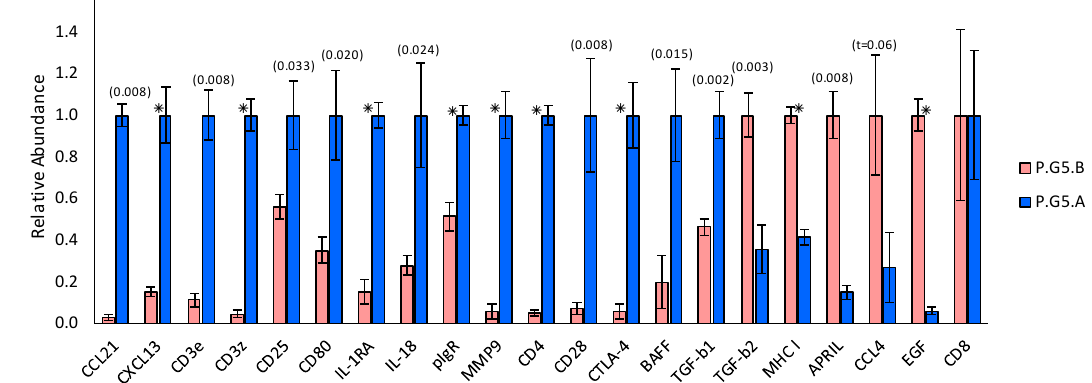
Figure 7. Relative transcript abundances in immune cell cluster samples microdissected from the subgroup P.G5.B gland (positive PC1 projection in Figure 2) and subgroup P.G5.A gland (negative PC1 projection in Figure 2). Only transcripts showing statistically significant differences are shown. Error bars indicate standard errors. * indicates p < 0.001; larger p - and t -values are given in parentheses. Values are normalized to the value; therefore, differences represent fold-changes. Mean abundances of messenger RNA (mRNA) for cluster of differentiation 8 (CD8) were similar in immune cell cluster samples from the two glands.